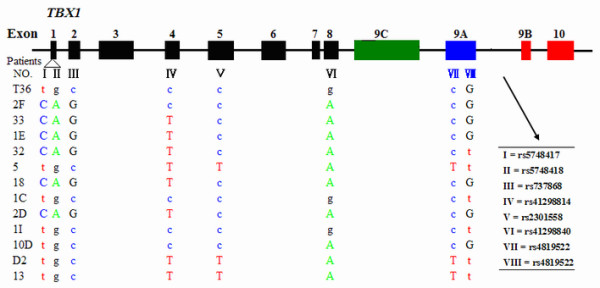
Positions of common variants of the 13 patients with 22q11.2 deletion. Ancestral alleles are written with small letters. The numerals from I to VIII are representative of the eight SNPs from rs5748417 to rs5746826, respectively. The corresponding identification numbers of the 13 patients with 22q11.2 deletions are listed at the left.